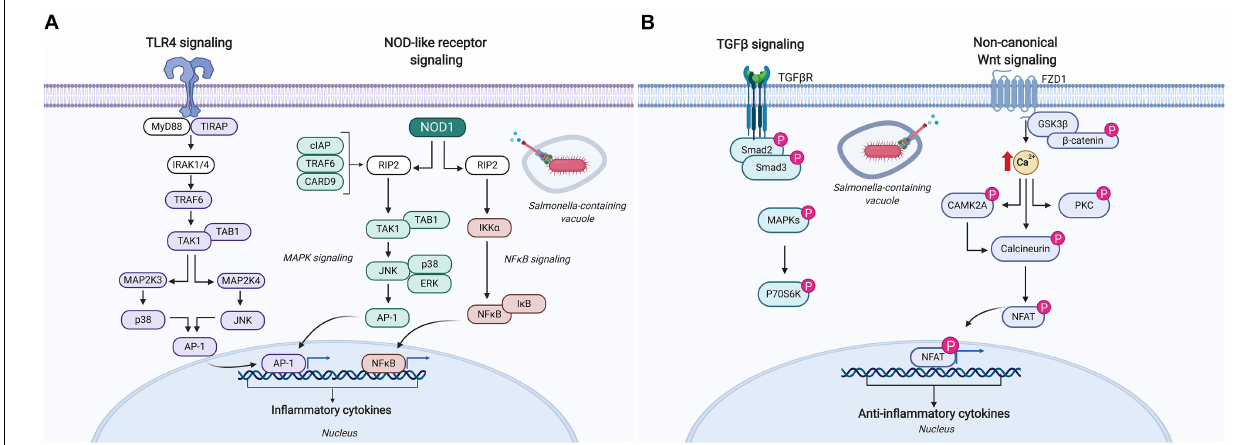
FIGURE 5 | Schematic representation of the immune signaling responses occurring in chickens infected with Salmonella. (A) Salmonella infection of chicken macrophages in vitro activates TLR4 and NOD-like receptor signaling pathways leading to the activation of unique transcriptional activators involved in inducing pro-inflammatory responses (64). (B) Kinome analysis of cecal tissue from Salmonella-infected chickens revealed differential phosphorylation of TGF- β and non-canonical Wnt signaling pathways suggesting a dampening of pro-inflammatory responses that supports Salmonella evading host immune defenses and establishing a persistent local infection (76). Figure is adapted from He et al. (64) and Kogut et al. (76); additional signaling responses have been characterized through biochemical analyses of TLR4, CARD9, and the NLRP3 inflammasome in bone marrow-derived macrophages and are described elsewhere (117–119). Protein identities in the figure that are colored (i.e., purple, blue, and pink) were identified as differentially phosphorylated ( p < 0.05) (64, 76). Figure is adapted from KEGG Pathway Mapper (https://www.genome.jp/kegg/mapper.html), and generated using BioRender. “P” designates protein in its phosphorylated state. AP-1, adaptor protein complex 1; CAMK2A, calcium/calmodulin-dependent protein kinase type II subunit alpha; CARD, caspase recruitment domain-containing protein; cIAP, cellular inhibitor of apoptosis; ERK, extracellular signal-regulated kinase; FZD1, Frizzled-1; GSK3 β , glycogen synthase kinase-3 beta; I κ B, NF- κ B inhibitor alpha; IKK α , inhibitor of nuclear factor kappa-B kinase subunit alpha; IRAK, interleukin-1 receptor-associated kinase; JNK, c-Jun N-terminal kinase; MAP, mitogen-activated protein kinase; MYD88, myeloid differentiation primary response protein; NFAT, nuclear factor of activated T-cells; NF κ B, nuclear factor kappa B; NOD, nucleotide-binding oligomerization domain-containing protein; P70S6K, ribosomal protein S6 kinase beta-1; PKC, protein kinase C alpha type; RIP, receptor-interacting serine/threonine-protein kinase; Smad, mothers against decapentaplegic homolog; TAB, TAK1-binding protein; TAK, mitogen-activated protein kinase; TGF β , transforming growth factor beta; TGF β R, TGF β receptor; TIRAP, toll/interleukin-1 receptor domain-containing adaptor protein; TRAF, TNF receptor-associated